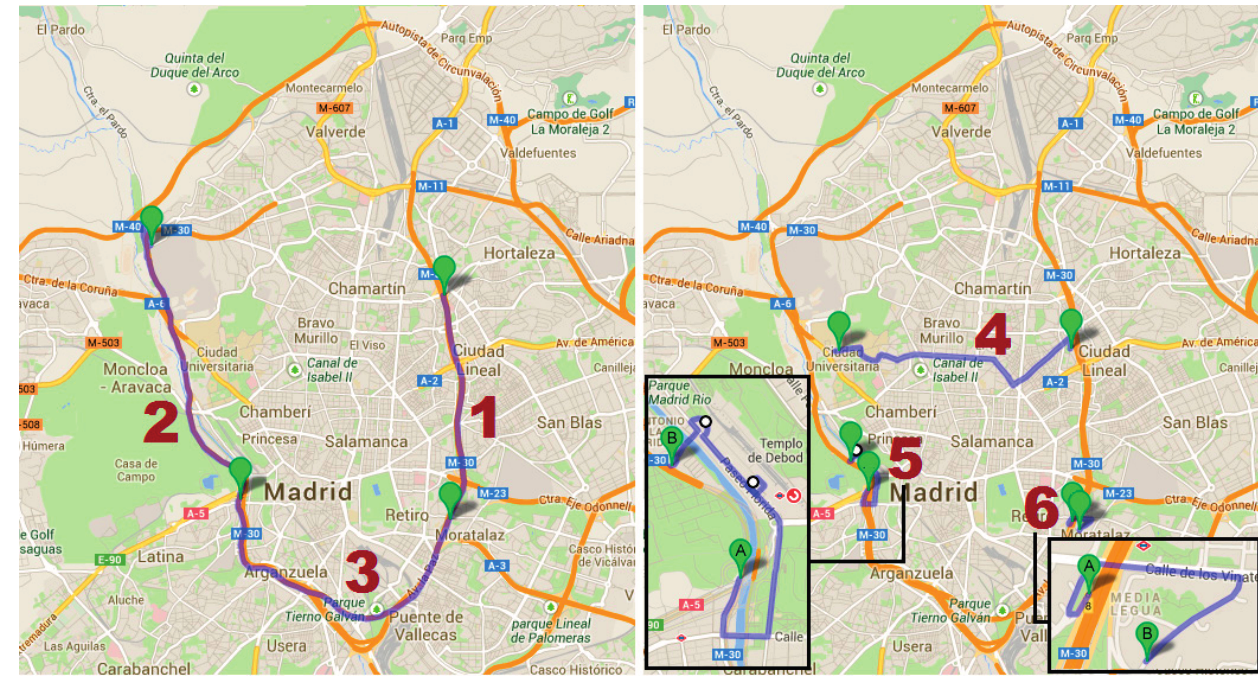
Figure 1. Monitored itineraries in the data collection campaign in